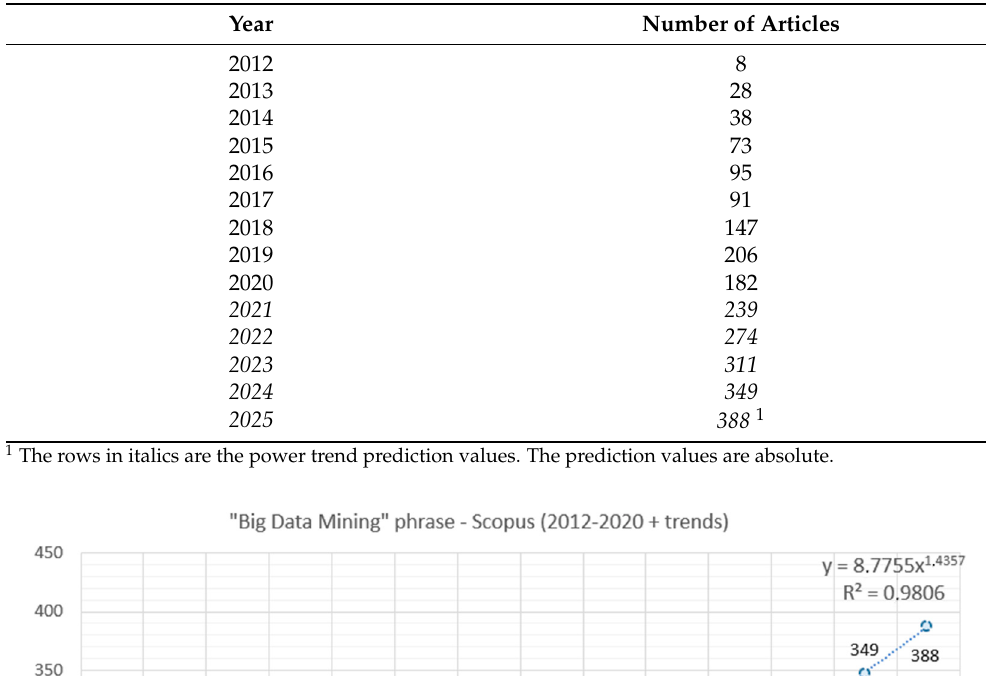
Table 4. Summary of the number of articles corresponding to the phrase “big data mining” in the Scopus database in 2012–2020 along with the prediction of the number of articles in 2021–2025.